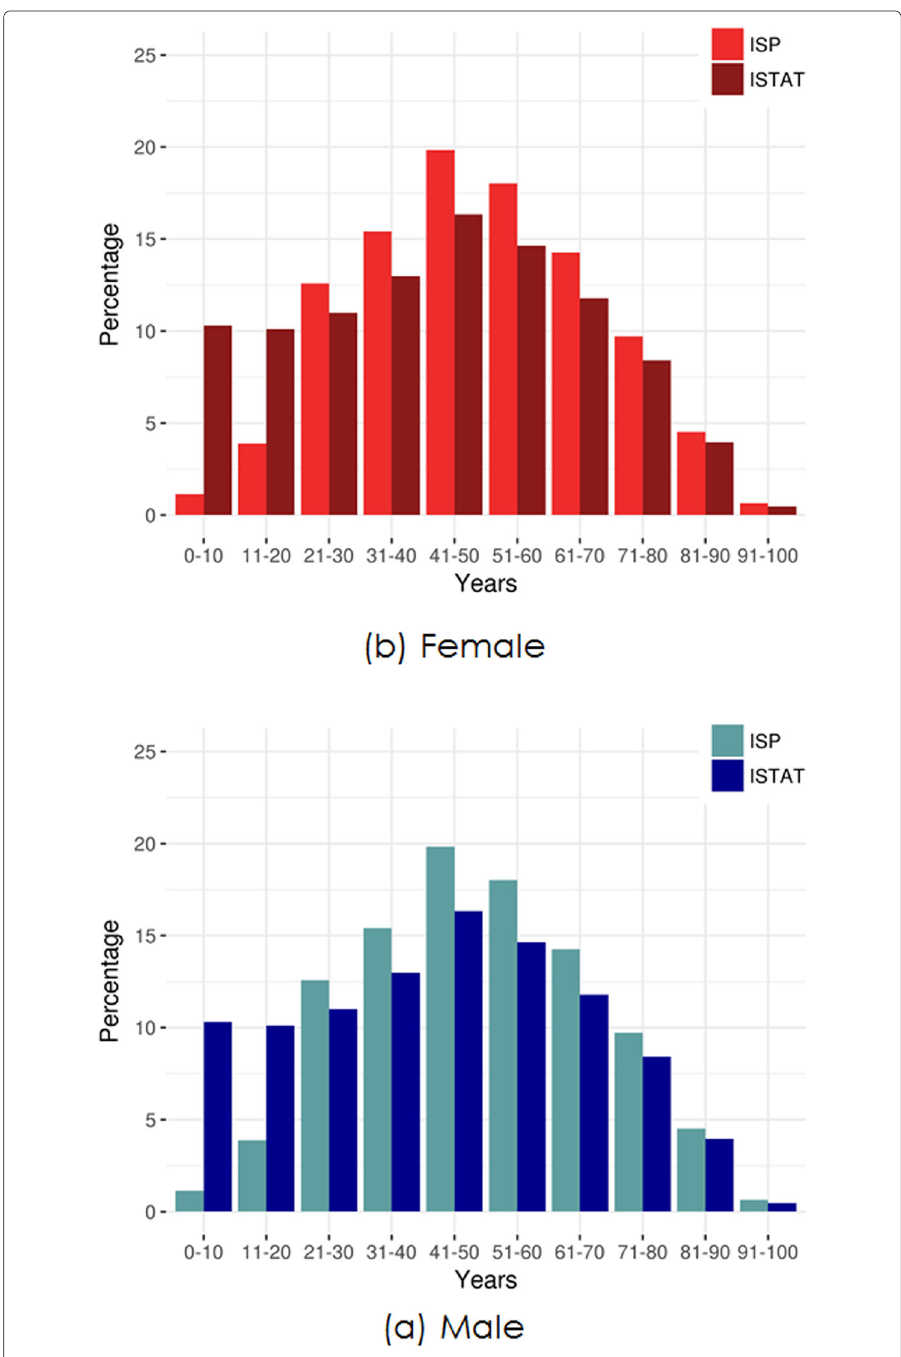
Fig. 1 Age distribution: Comparison among age frequency histograms for ISP bank account holders and Italian population, both for female (above) and for male (below). We can see that ISP dataset reflects Italian population, with the exception of elderly and underage citizens. Official Italian population by age have been retrieved from the ISTAT on-line data base (Statistiche Demografiche ISTAT 2017)